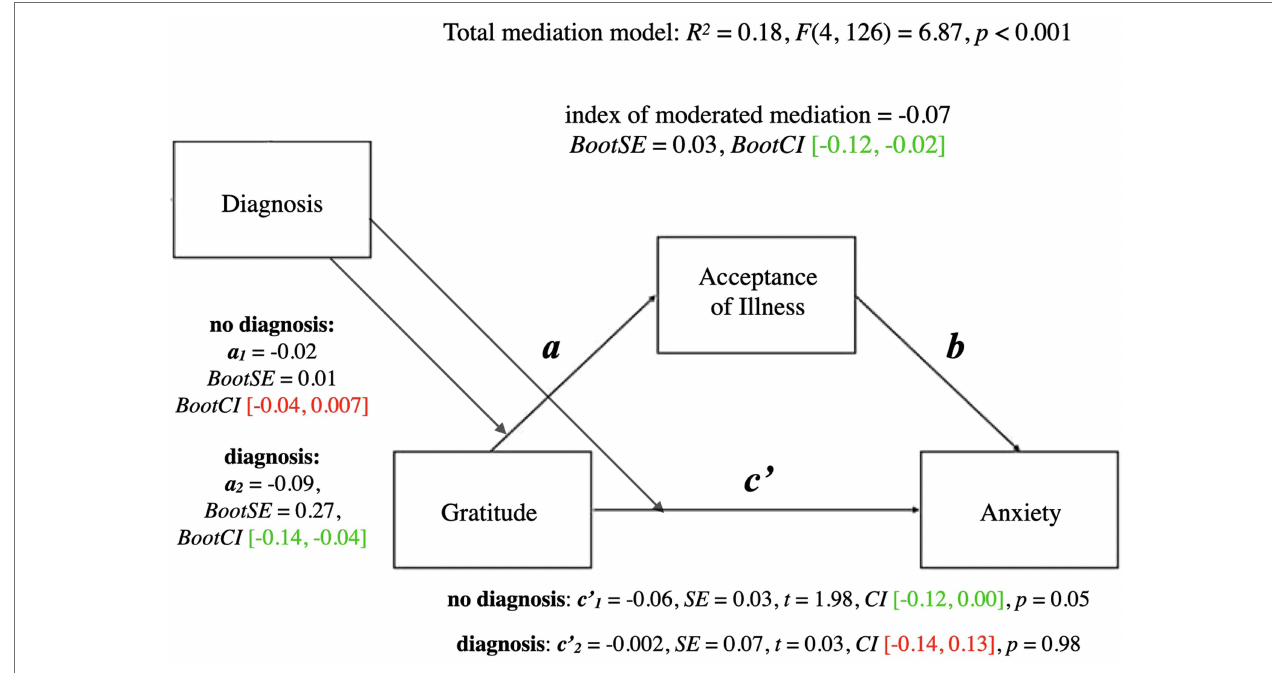
FIGURE 5 | Moderated mediation model for gratitude and anxiety with diagnosis as moderator. a, conditional indirect effect of gratitude on wellbeing through acceptance of illness; c', conditional direct effect of gratitude on wellbeing index of moderated mediation = difference between conditional indirect effects CI marked green indicate significance; red – lack of significance.